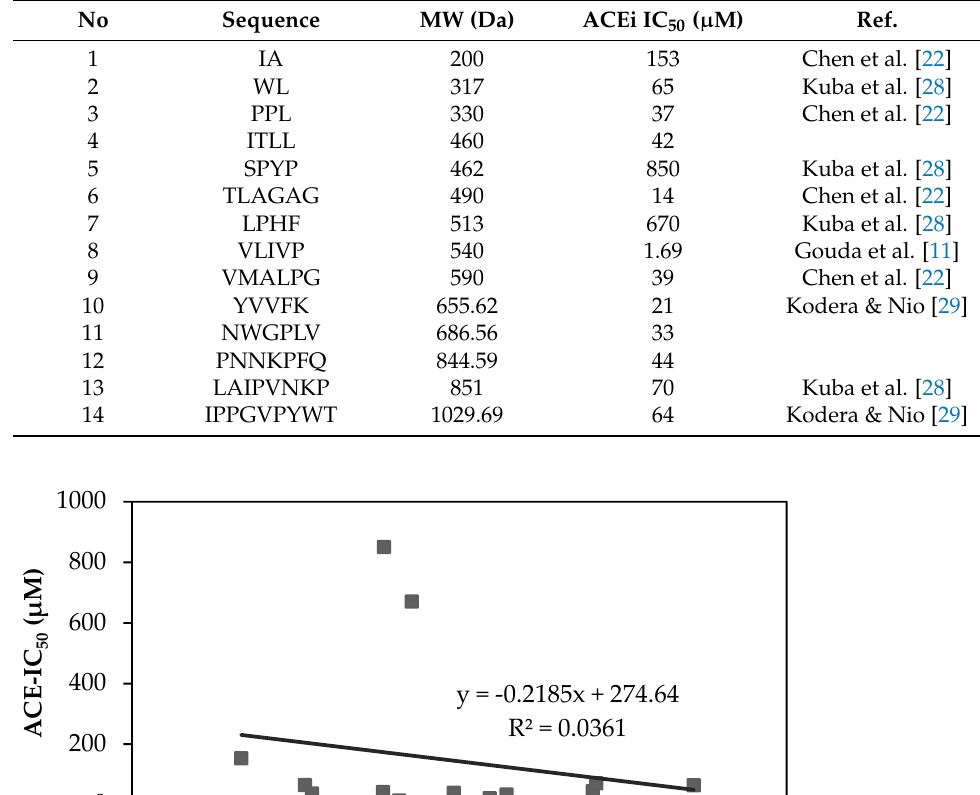
Table 4. Molecular weights and inhibition values of ACEi bioactive peptides.